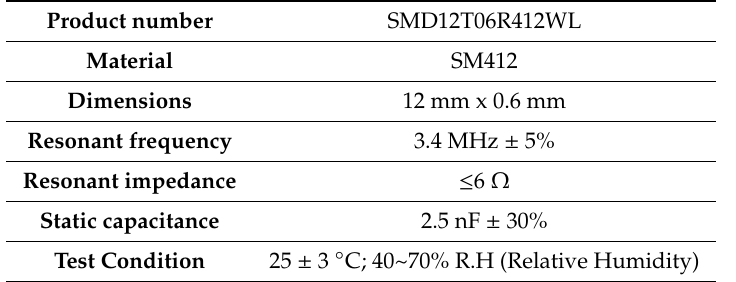
Table 3. Performance parameters of piezoelectric sensors.